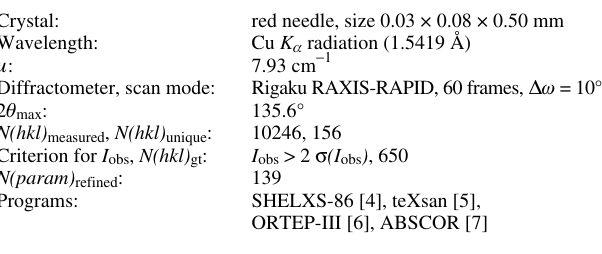
Table 1. Data collection and